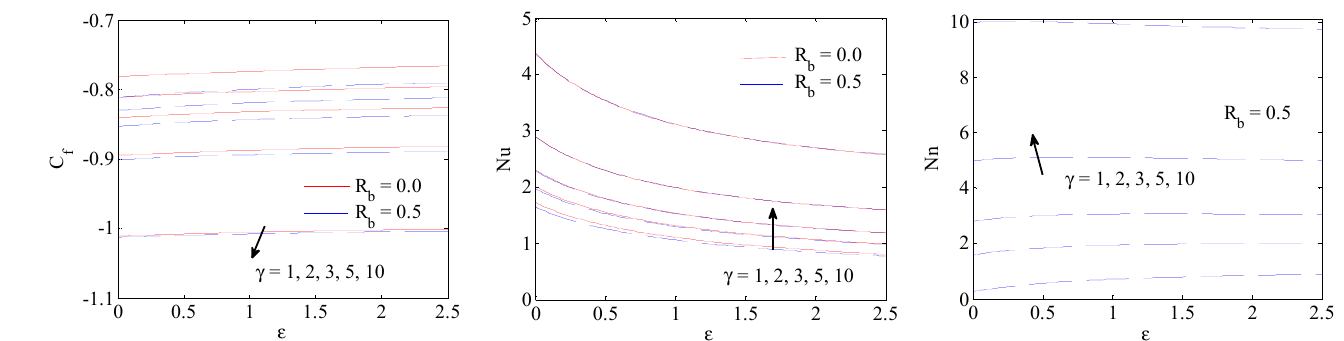
Figure 4. Fluctuations of C f , Nu and Nn due to n factor.